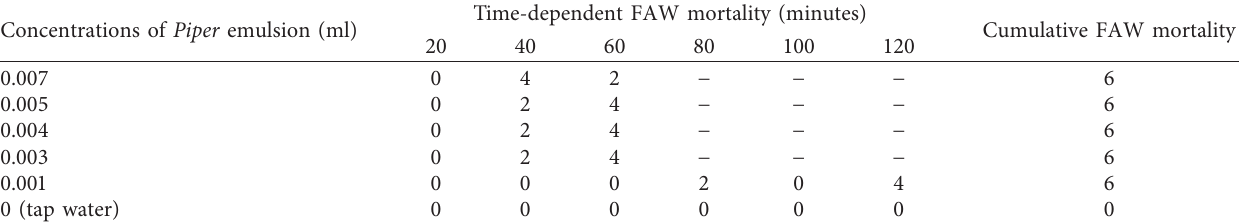
Table 1: Laboratory bioassay of five concentrations of the West African black pepper extract against fall armyworm (FAW). Concentrations of Piper emulsion (ml)